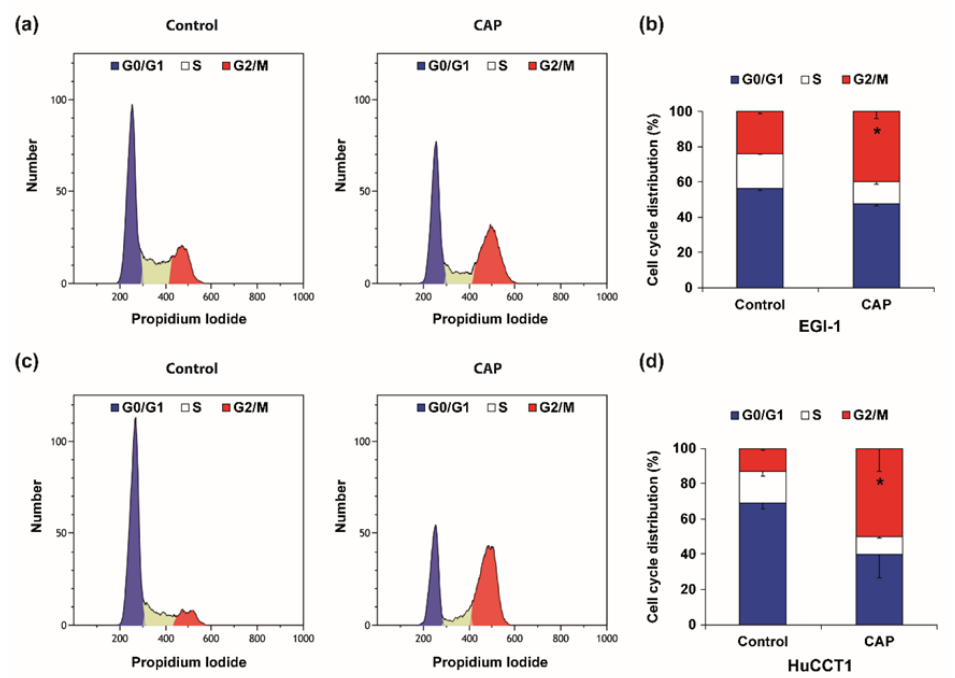
Figure 5. ( a – d ) Representative flow cytometry cell cycle measurement ( a , c ) and graphical representation of the cell cycle distribution ( b , d ) of EGI-1 ( a , b ) and HuCCT1 ( c , d ) CCA cells after 24 h of exposure to culture medium pretreated with CAP for 3 min. (9 kV, 30 kHz, 14%, gap of 7 mm). Cell populations in G0 / G1, S, and G2 / M phases are given as percentage of total cells. Values are expressed as means ± SEM from at least three independent cultures. *, p < 0.05; as compared with control cells.